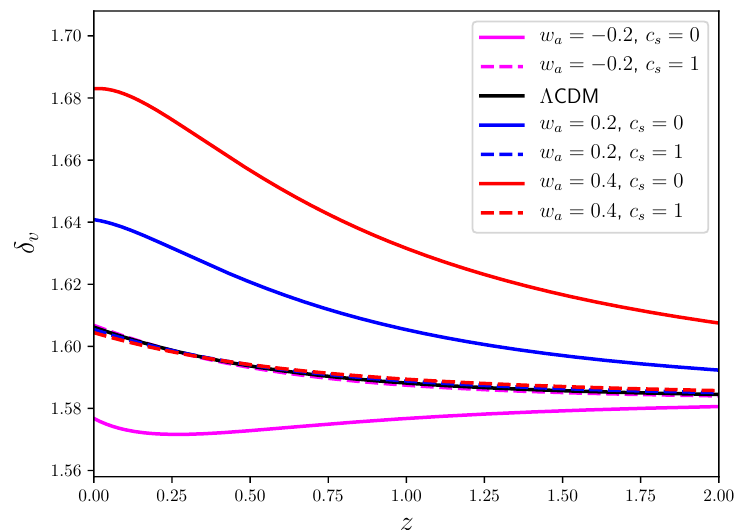
Figure 3. Virialization threshold, δ v , for homogenous and CDE models, with w 0 = and different values of w a and c s indicated in the legend. The black solid line represents the Λ CDM values and is barely distinguishable from the cases with